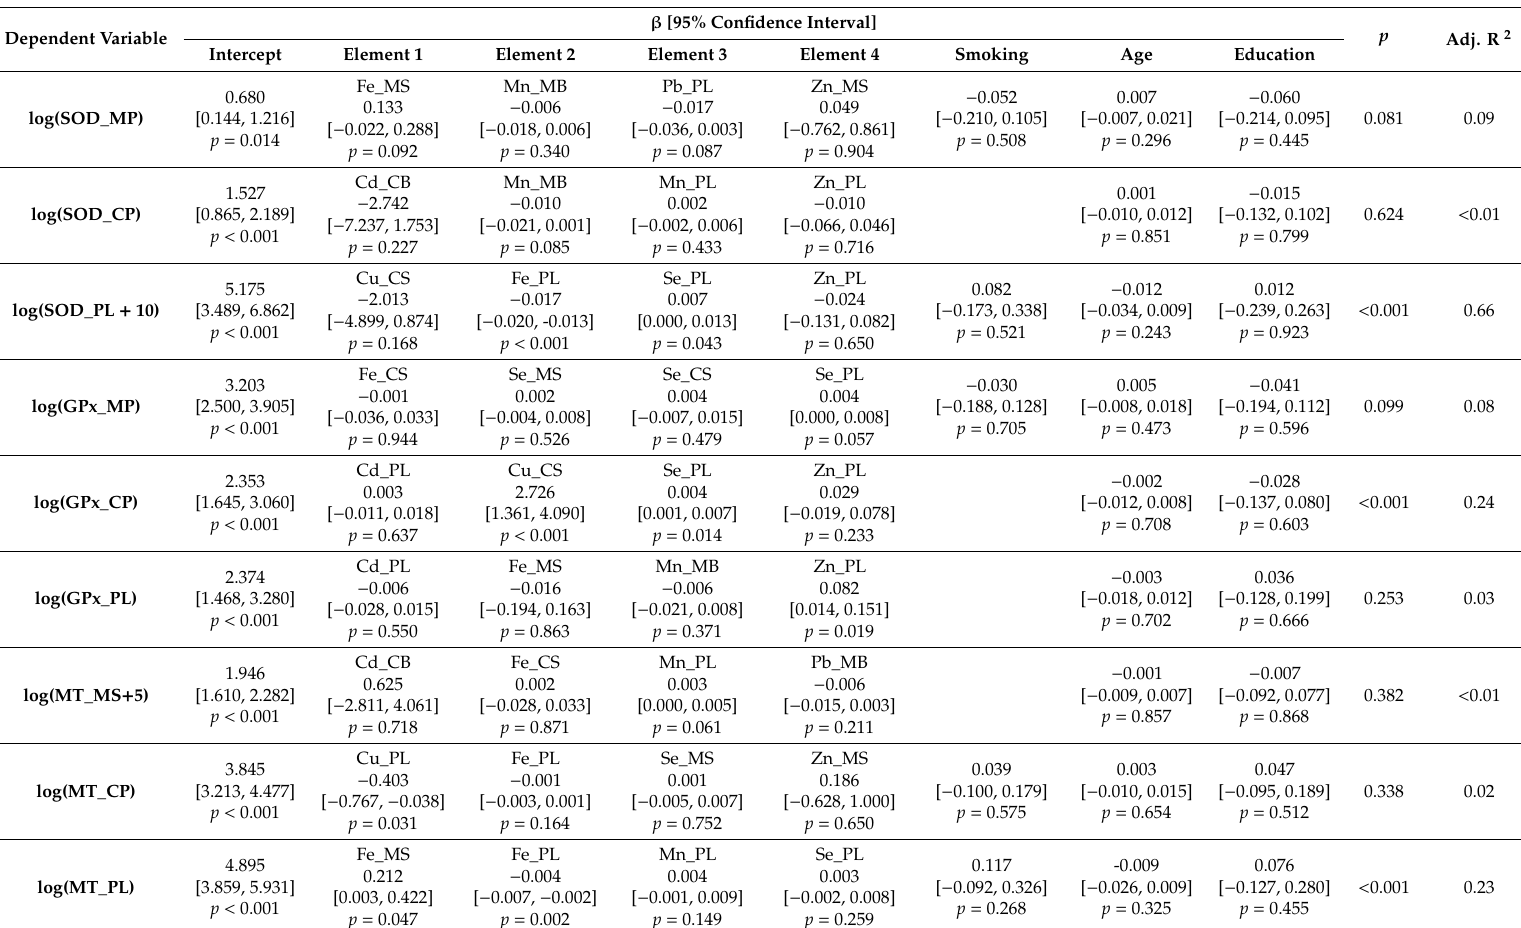
Table 3. Results of multiple regression analyses. Each row represents results of one multiple regression model with four elements identified from SDA analysis, smoking, age and education as predictors. Smoking was included as a predictor only in models without Cd as a